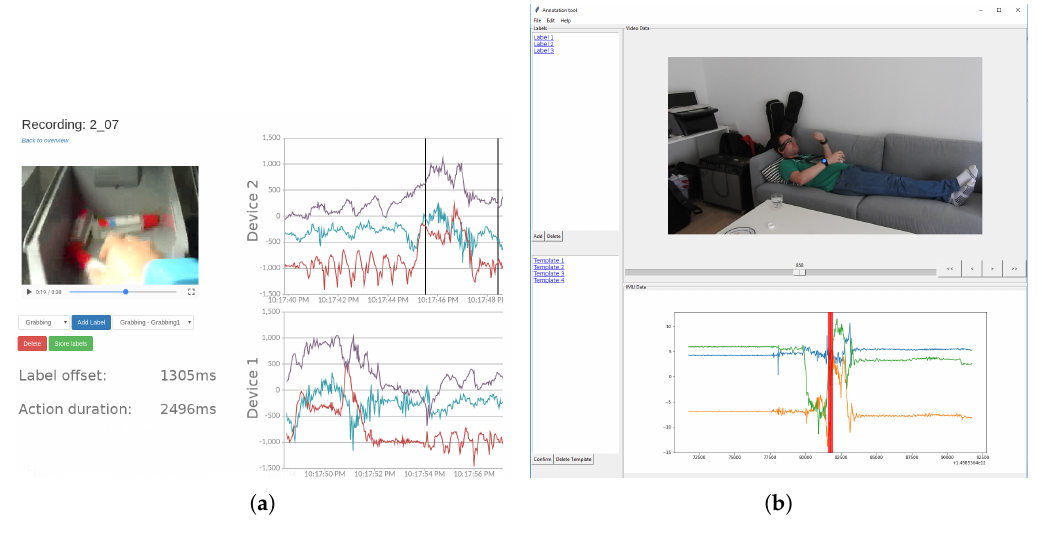
Figure 4. Developed labeling tools. First version running in a browser, second version as a standalone application. ( a ) Old web application; ( b ) New desktop